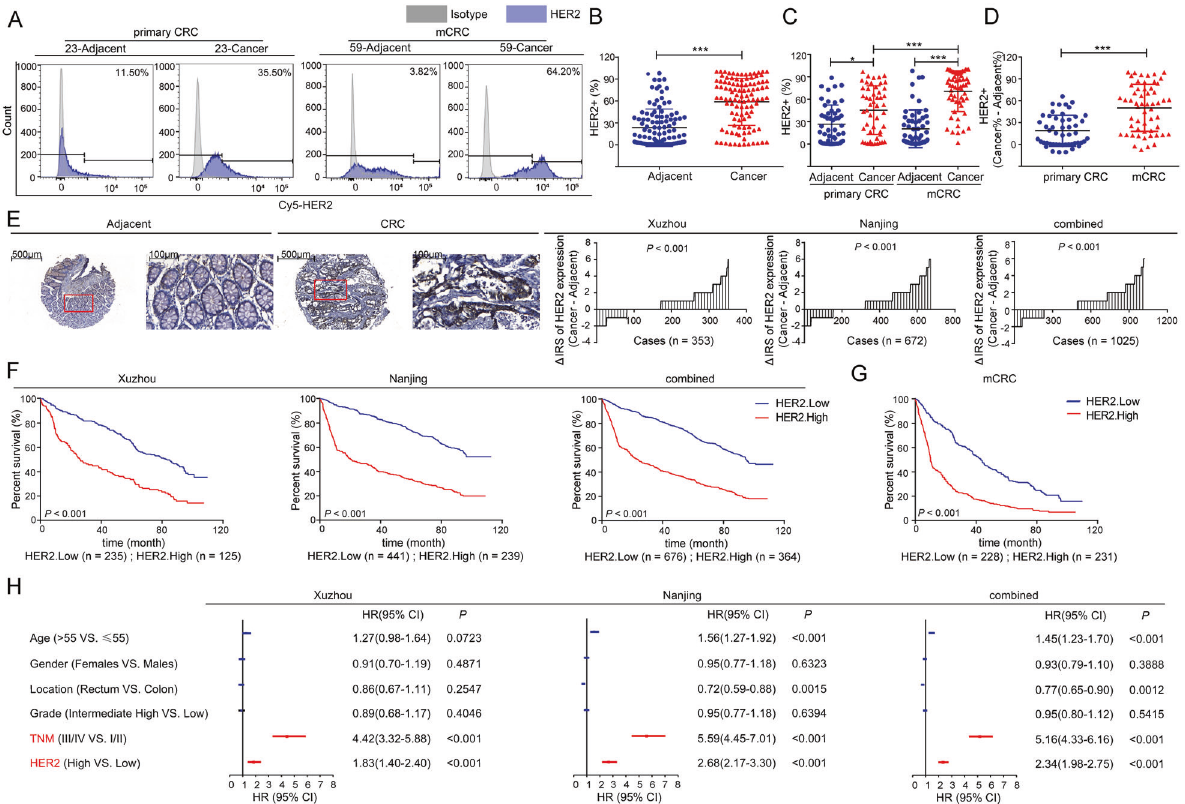
Fig. 2 Expression of HER2 in tissues. A A total of 106 pairs of fresh CRC tumors and matched adjacent tissues were assessed by fl ow cytometry analysis, and the representative images are shown. B The expression levels of HER2 in fresh tissues of CRC patients ( n = 106, *** P < 0.001, two-tailed t -test). C The expression levels of HER2 in fresh tissues of CRC patients with different progression. (* P < 0.05, *** P < 0.001, Kruskal – Wallis test followed by the Dunn ’ s multiple comparison test). D The difference in the expression levels of HER2 between fresh CRC tumors and matched adjacent tissues (Cancer% - Adjacent%) of CRC patients with different progression ( *** P < 0.001, two-tailed t -test). E Left panel: The levels of HER2 in TMA were evaluated by IHC analysis, and the representative staining images are shown. The scale bar is marked in each image. Right panel: The difference in staining score between CRC lesions and adjacent tissues (Cancer - Adjacent) in Xuzhou, Nanjing, and combined cohorts are shown. F KM curves depicting the overall survival of CRC patients based upon tumoral HER2 levels. Left to right: Xuzhou, Nanjing, and combined cohorts. G KM curves depicting the overall survival of mCRC patients based upon tumoral HER2 levels. P values were calculated by the Log-rank test. H Multivariable COX regression analyses (adjusted age, gender, location, grade, TNM stage and HER2 expression) were performed in our cohorts. Bars correspond to 95% con fi dence interval (CI). HR hazard